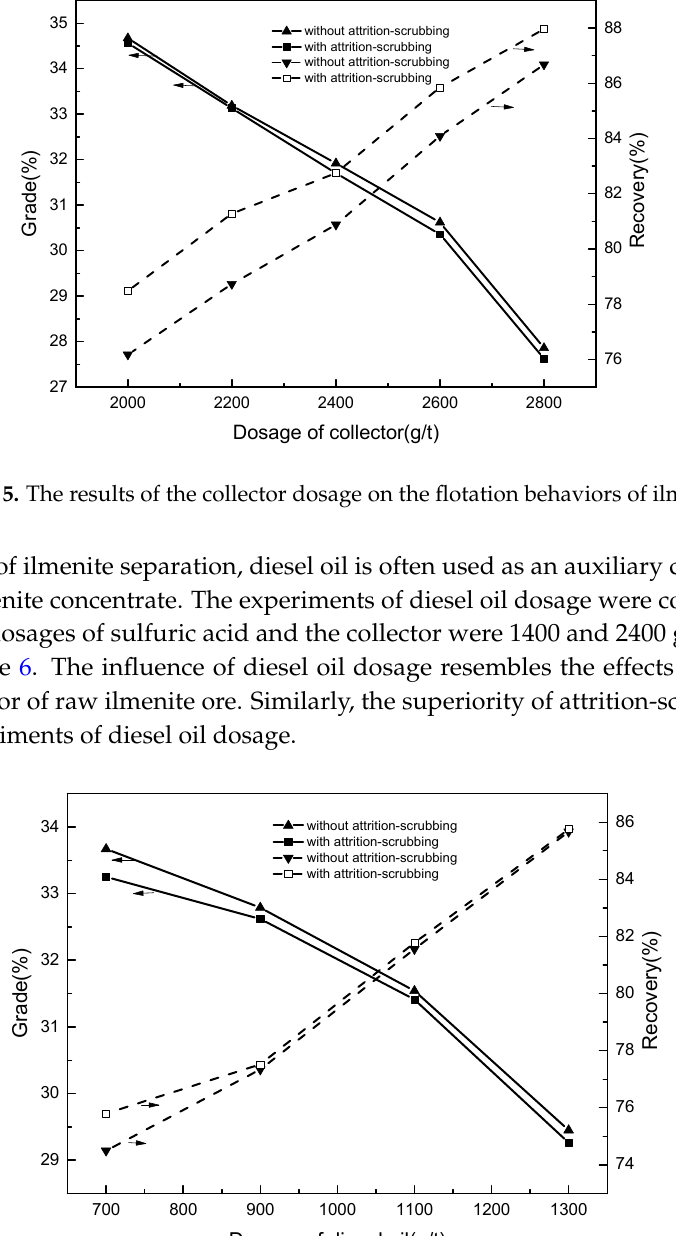
Figure 6. The results of diesel oil dosage on the flotation behaviors of ilmenite.